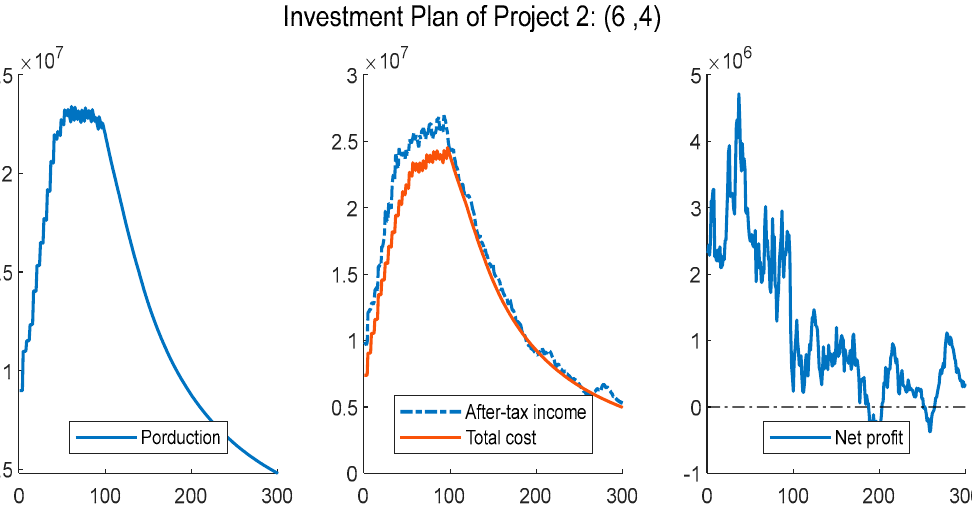
Figure 12. Production, income, cost and, net profit of project 1.